Question: Identify the chart type used in this figure.
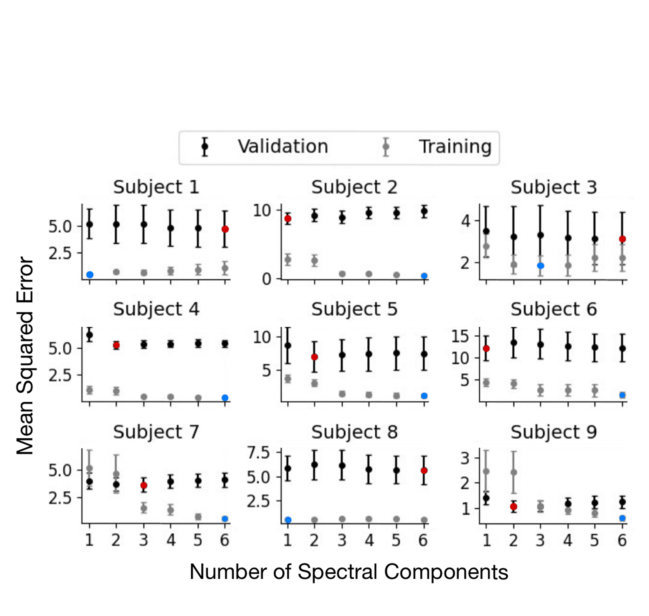
Answer: line